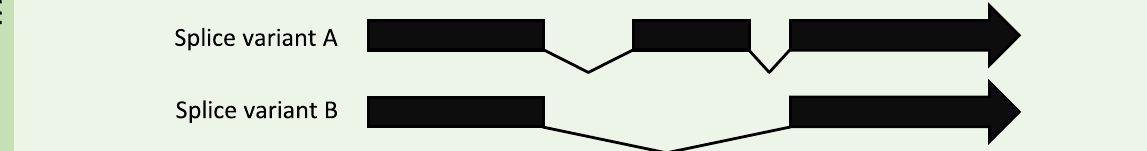
Fig 4. Summaryof RNA sequencing. Within the organisms, genesare transcribed and spliced(in eukaryotes)to producemature mRNA transcripts (red). The mRNA is extracted from the organism, fragmented and copied into stable double-stranded–cDNA (ds-cDNA; blue). The ds-cDNA is sequencedusing high-throughput, short-readsequencing methods. These sequencescan then be alignedto a reference genome sequenceto reconstruct which genome regionswere being transcribed. These data can be used to annotate where expressed genes are, their relative expressionlevels, and any alternativesplice